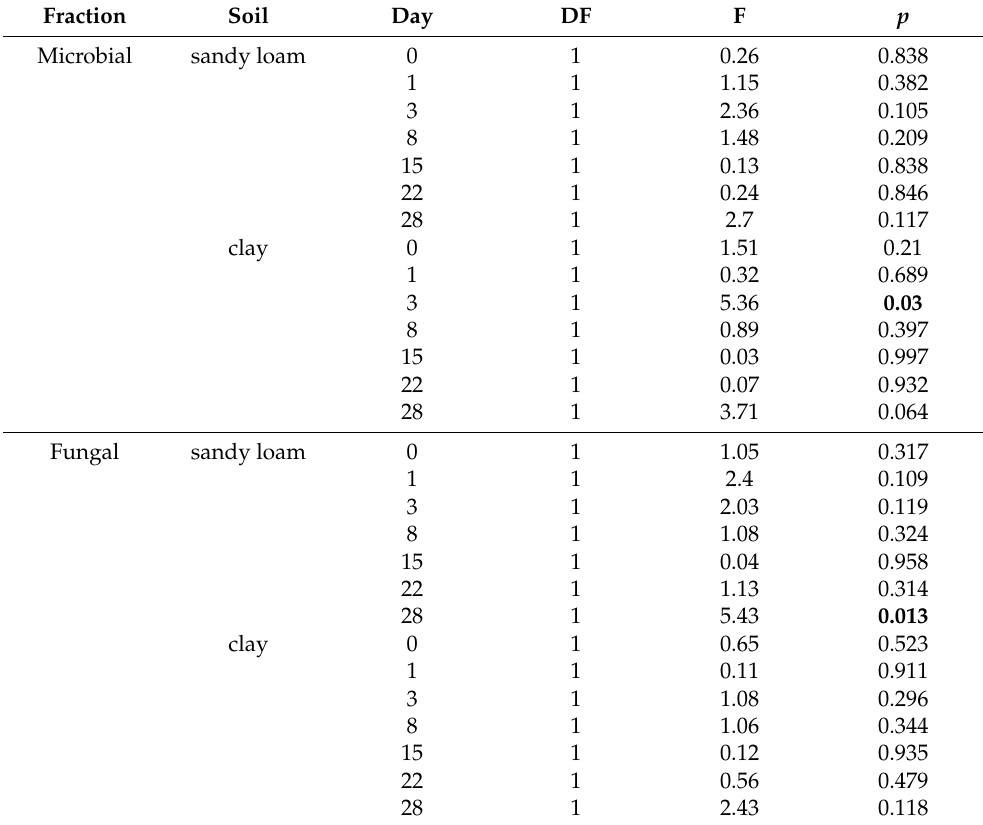
Table A4. Test statistics of the Monte Carlo permutation test used to assess the significance of the effects of AFB1 concentration on the multivariate response (canonical coefficient of PRC). Significant